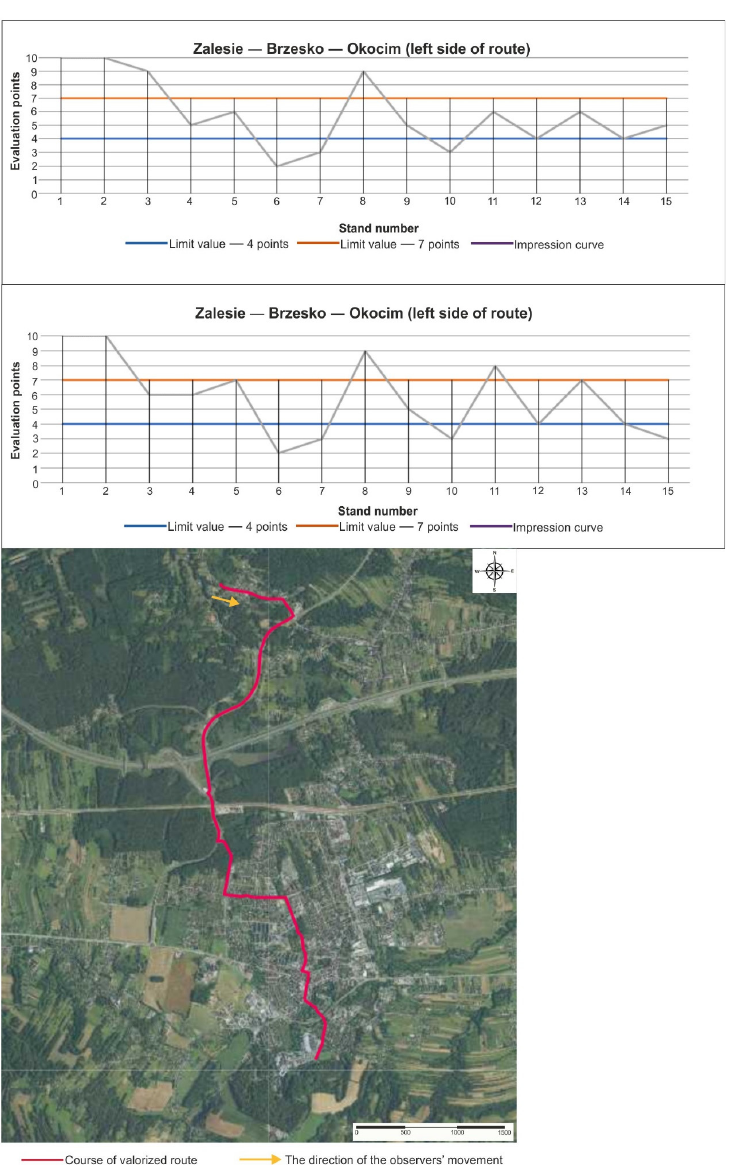
Figure 11. Impression curves for the Zalesie—Brzesko—Okocim route (Commune of Brzesko).